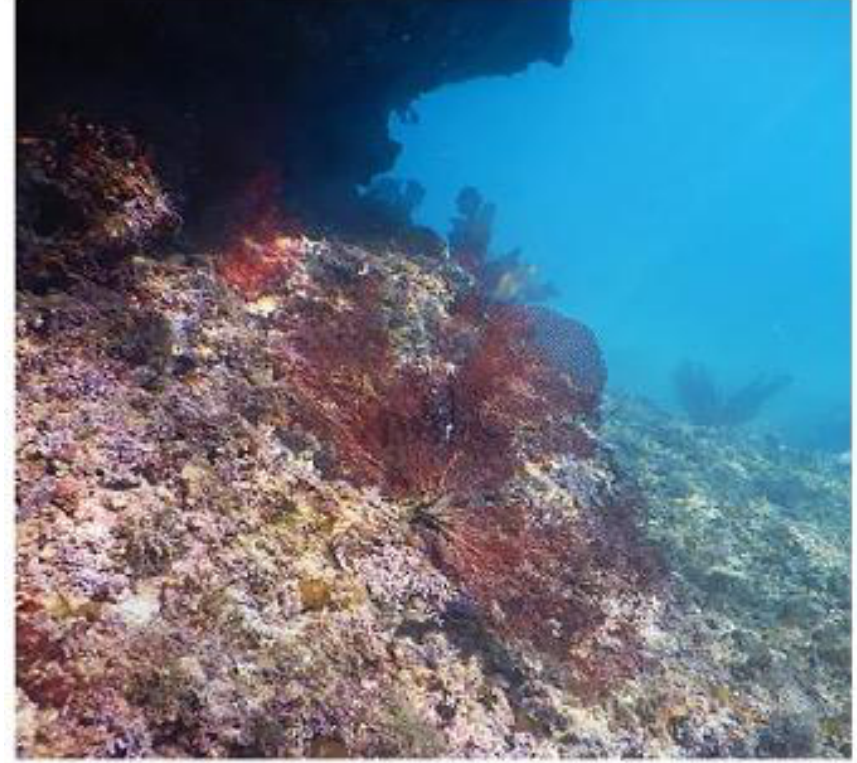
Figure 7. Underwater photo showing the natural habitat of the sea fan Pacifigorgia adamsi growing in place on the seabed at an upper depth limit of about 5 m.